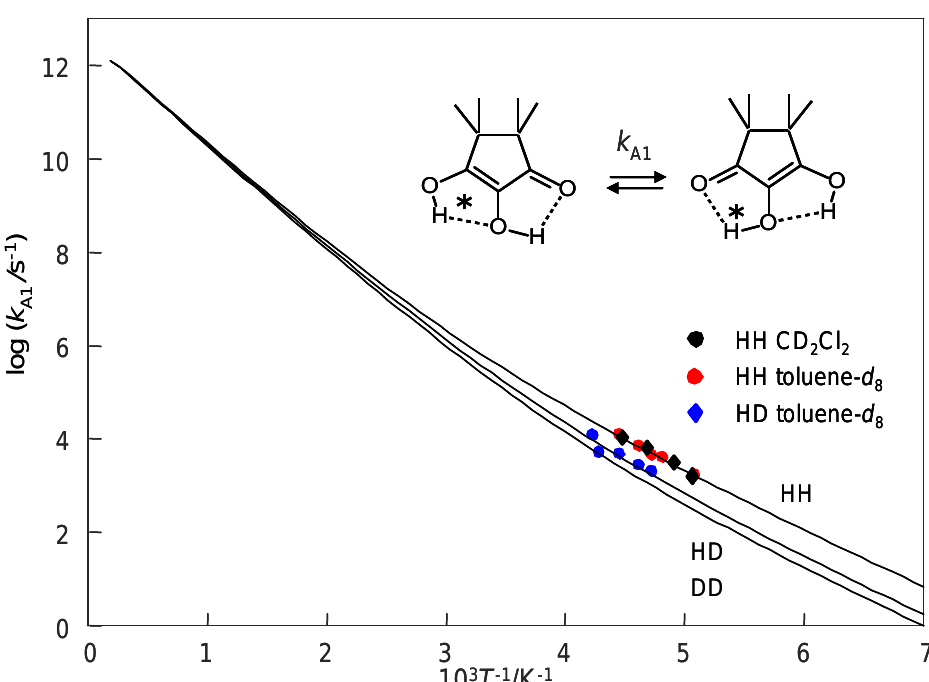
Figure 15. Arrhenius diagram of the tautomerization of TMRA. Plot of log k vs. the inverse tempera- ture in the full temperature range. The Arrhenius curves were calculated using the Bell–Limbach tunneling model [3–6,19] using the parameters of Table 5. Table 5. Bell-Limbach tunneling model parameters of the tautomerism of TMRA. Solvent Toluene- d 8 Toluene- d 8 CD 2 Cl 2 HH HD HH